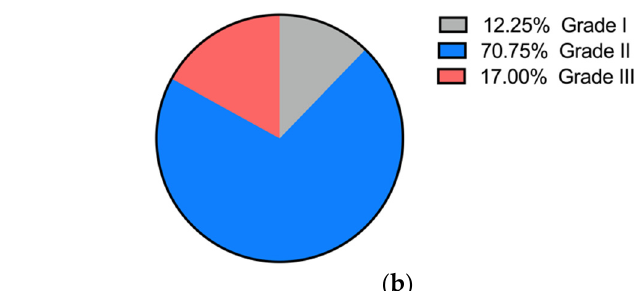
Figure 9. ( a ) Proportion of each caries risk grade; ( b ) Proportion of each treatment difficulty grade.